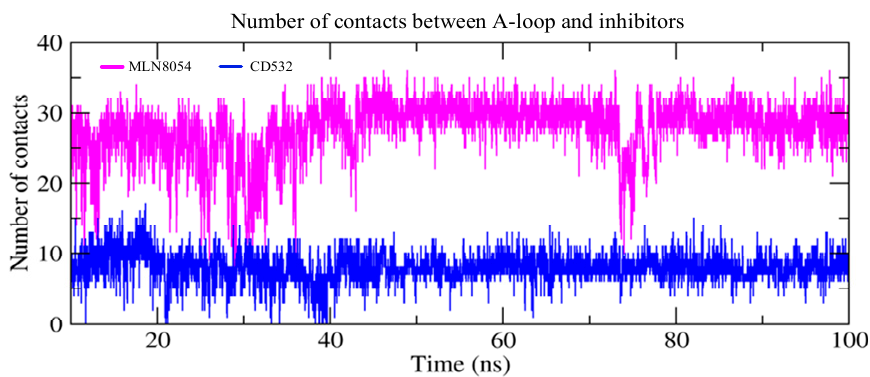
Figure 8. The number of contacts between the A-loop and the inhibitors as a function of simulation time in two closed/inactive structures including Aurora-A/MLN8054 (2WTV, pink), and Aurora-A/CD532 (4J8M, blue).